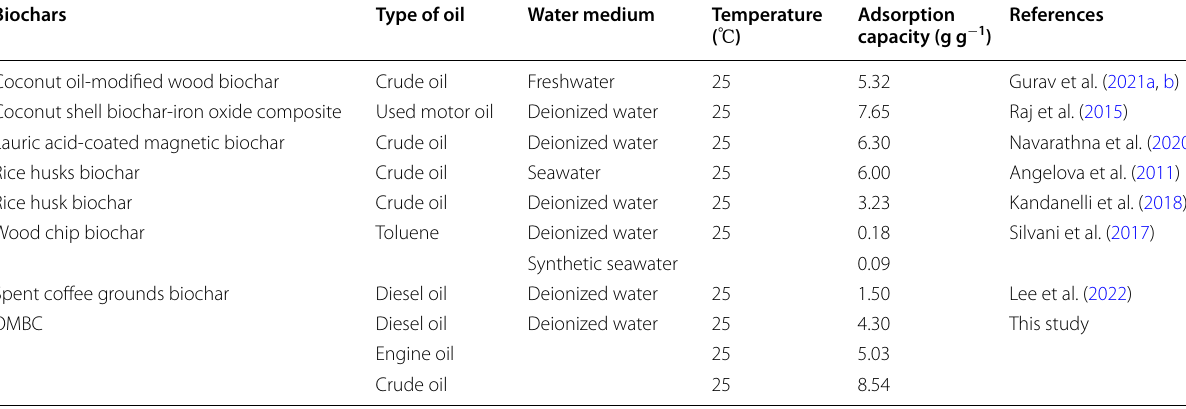
Table 2 Comparison with the oil sorption capacity of biochar in literatures